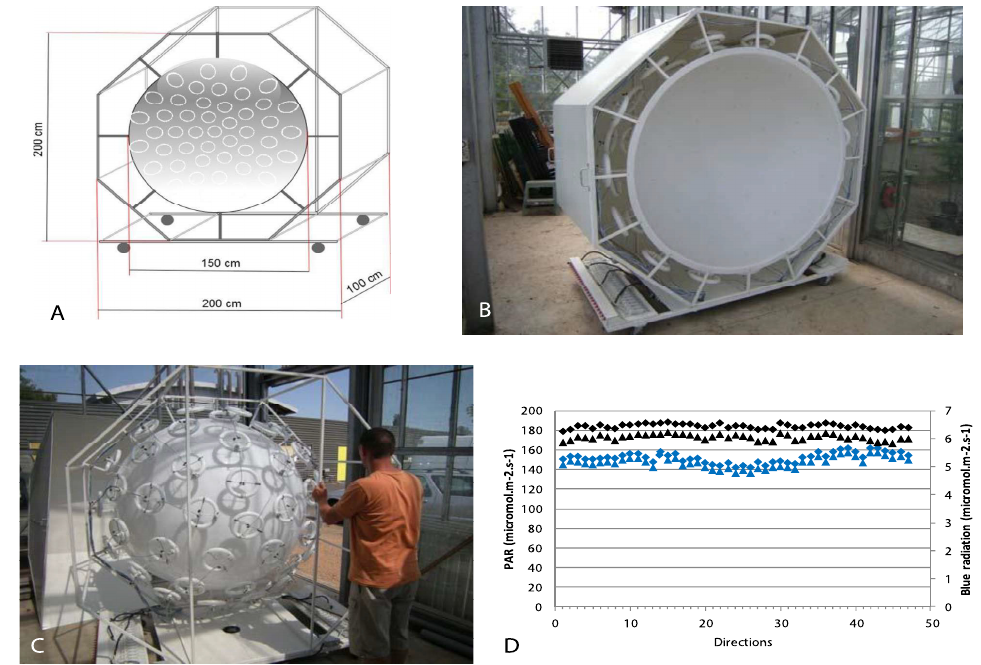
Fig 2. Isotropic light device. A: 3D quoted scheme of the isotropic light device. B: View of one hemisphere showing the turtle pattern of circular neon tubes at the periphery of the white plastic hemisphere. C: View of one hemisphere covered with metallic plates to concentrate the lighting towards the inside of the hemisphere. D: Measurements of PAR and blue radiation in the two spheres in 46 directions with an optic fiber mounted on a robot set in the center of the sphere. Black symbols: PAR; blue symbols: blue